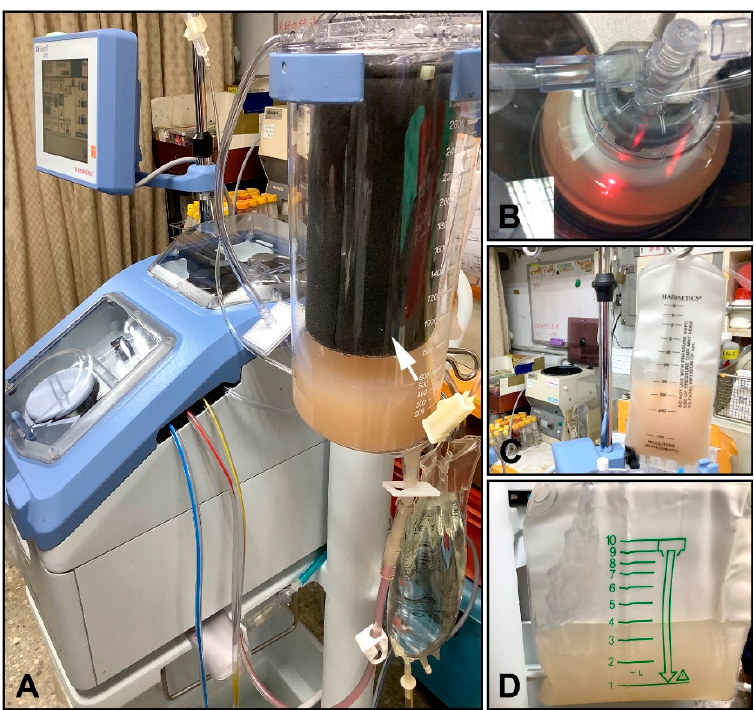
Figure 2. Liver cell isolation through the Cell Saver ® strategy. ( A ) Liver cells were filtered through a black sponge (arrow) with an average pore size of 100 µ m. ( B ) Cell washing through centrifugation. ( C ) Cell suspension was collected after centrifuged washing. ( D ) Waste washing solution.